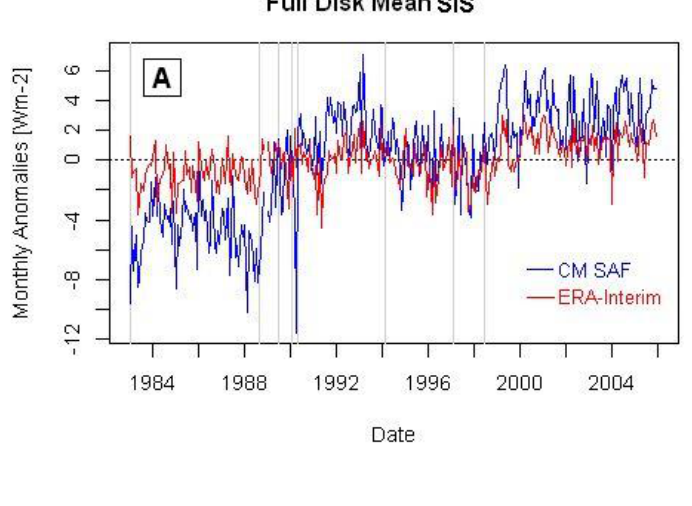
Figure 6. Full-domain mean series of the CM-SAF and ERA-Interim SIS data fields ( A ), difference time series ( B ) and SNHT test statistic for the difference series ( C